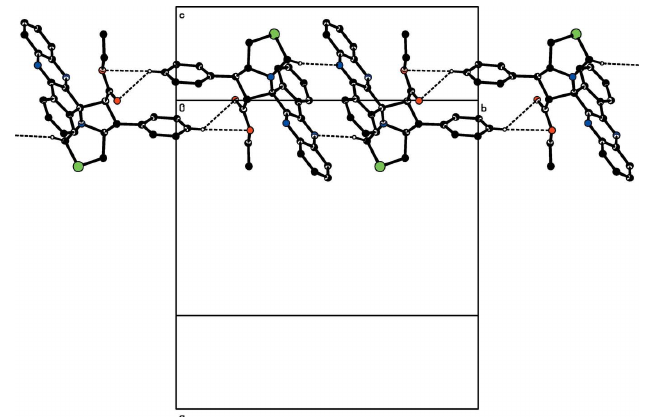
Figure 3 Part of the crystal structure of the title compound, showing the formation of R 2 (18) and R 2 (24) graph-set motifs. Dashed lines indicate hydrogen 2 2 bonds. The H atoms not involved in the hydrogen bonding have been omitted for the sake of clarity.